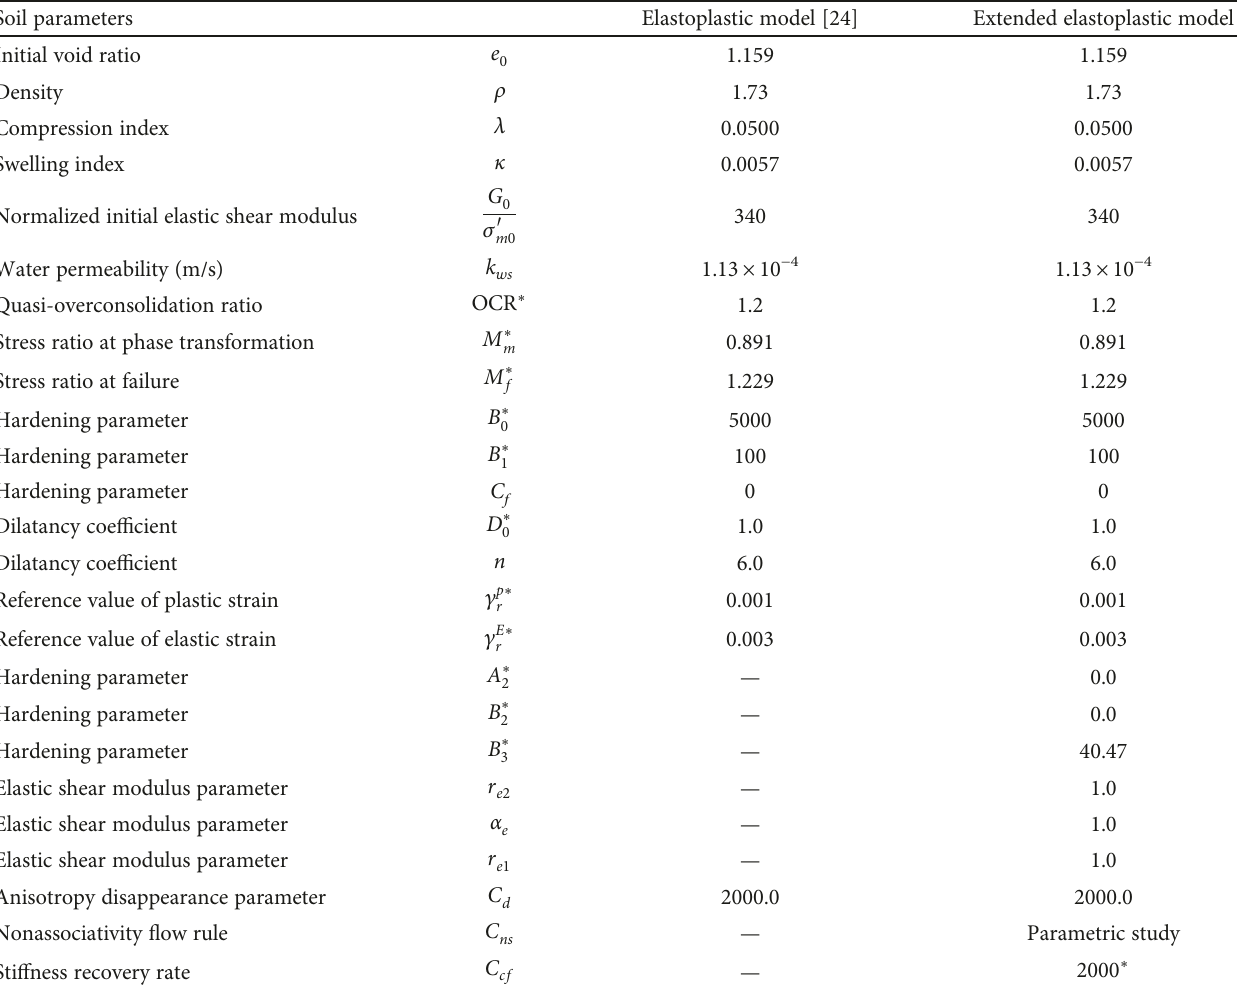
Table 1: Material parameters of Naruse